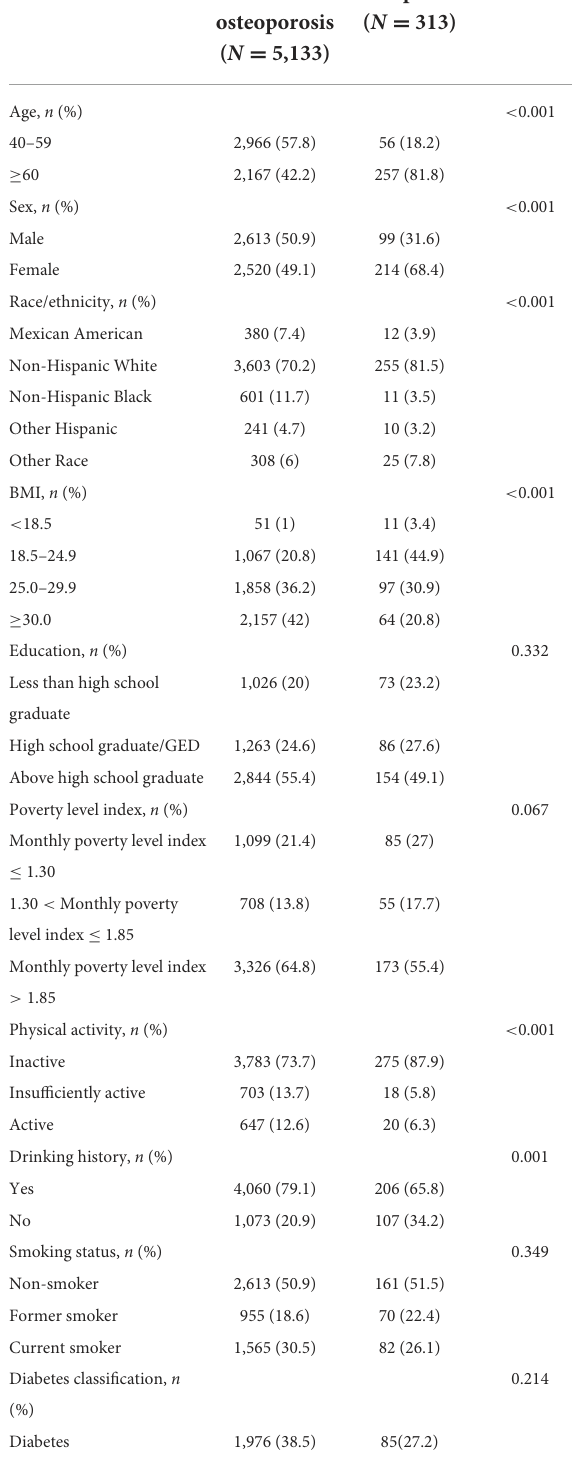
TABLE 2 Characteristics of the study